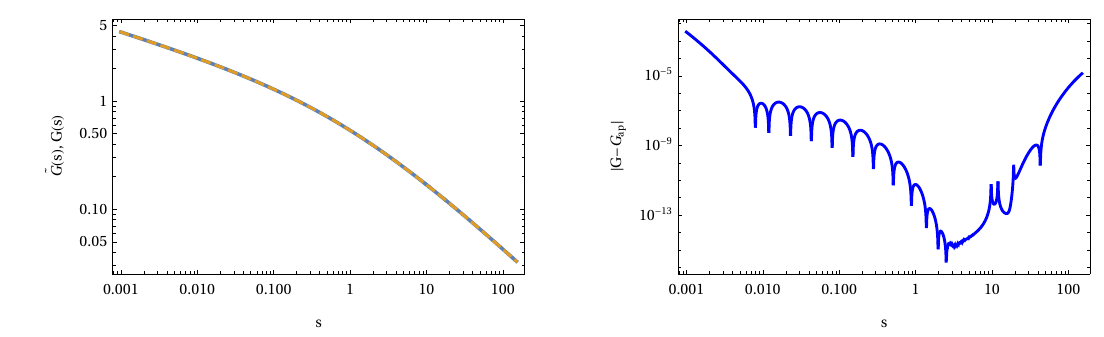
Figure 14. Approximation of the transfer function G ( s ) for a three parameter fractional relaxation equation represented by (96). The left panel shows the exact transfer function G ( s ) with χ 0 = 1, τ = 1, α = 1/2, β = 2/3, and γ = 9/10 in connection with the approximation using Thiele’s algorithm. The right panel shows the local error between the exact function and its approximation. The total number of point used in the approximation is m = 2 N + 1 = 35.